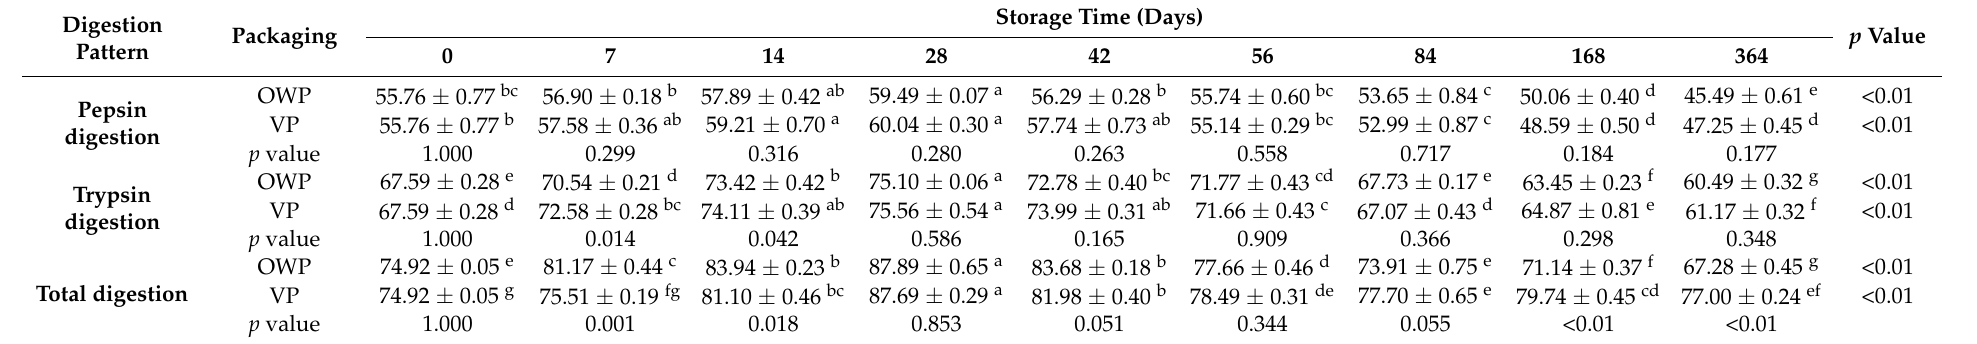
Table 1. The in vitro digestibility of yak rumen SMP during frozen